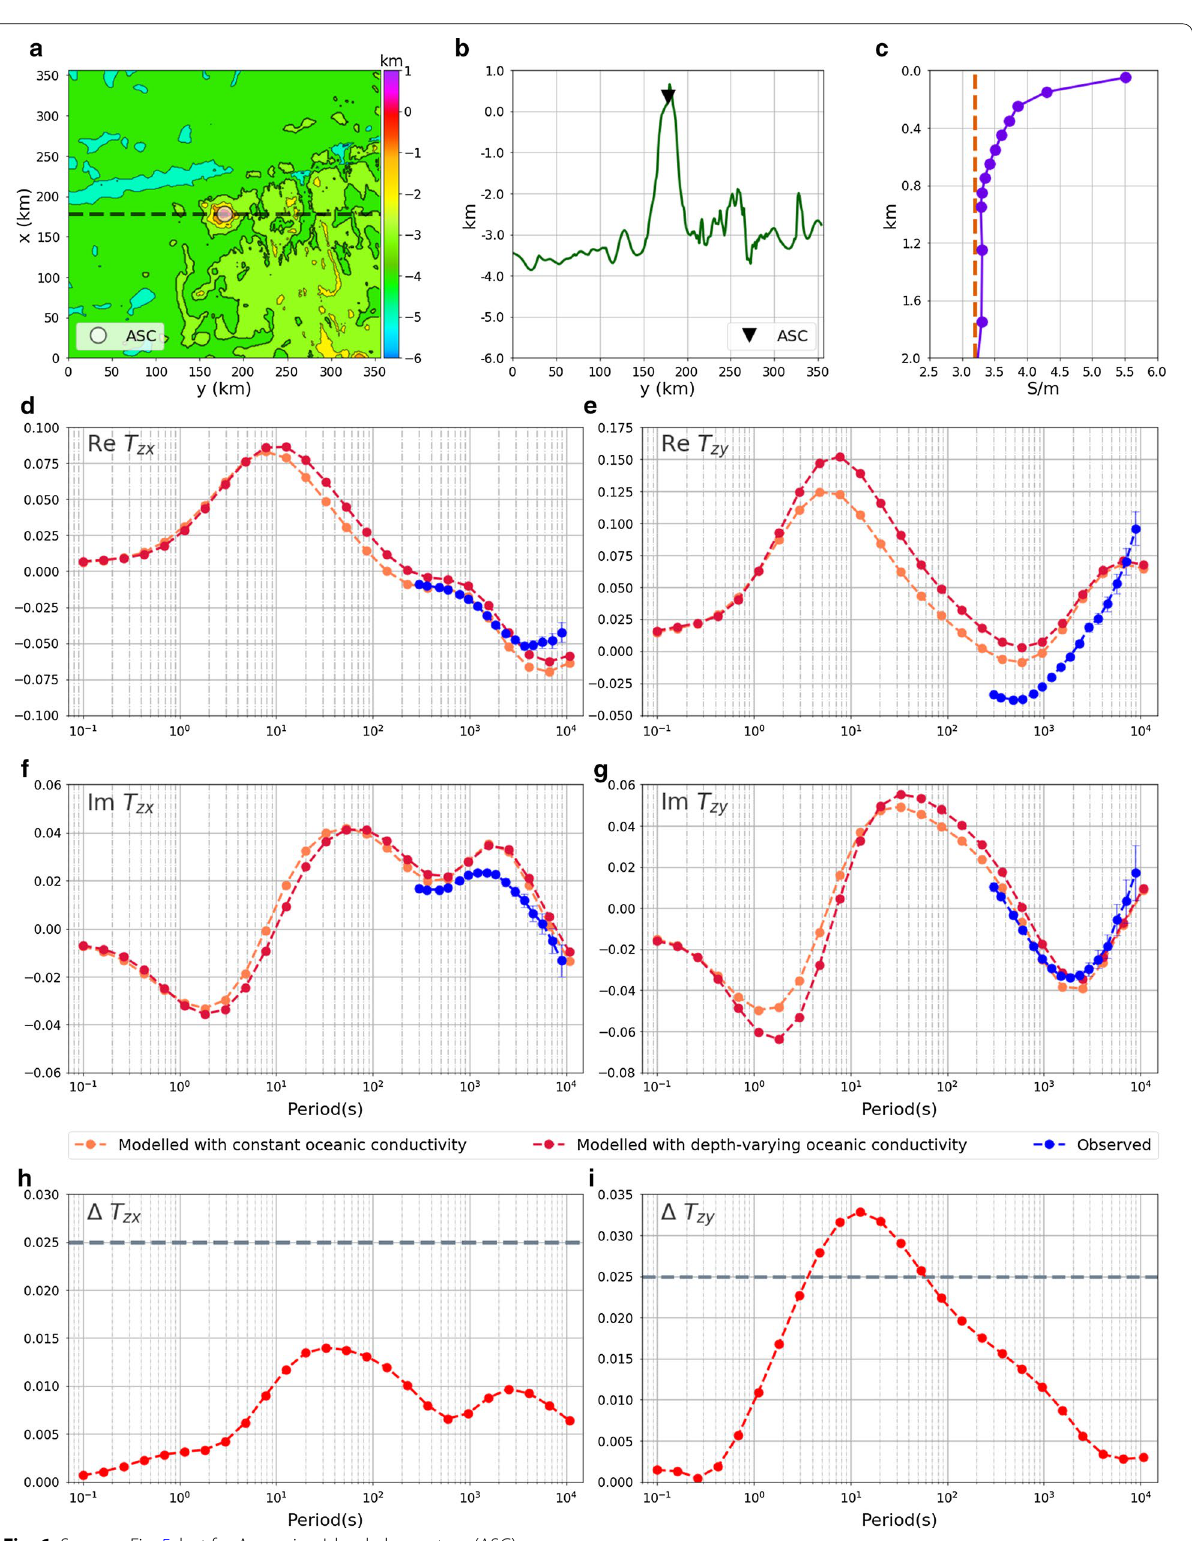
Fig. 6 Same as Fig. 5, but for Ascension Island observatory